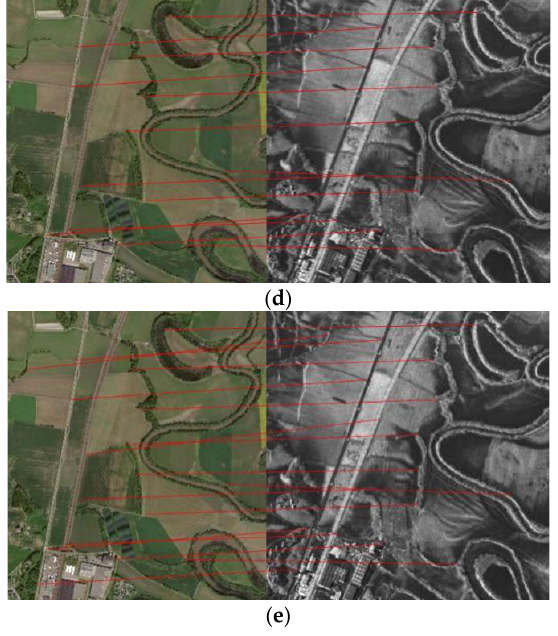
Figure 3. ( a ) Optical image; ( b ) SAR image; matches found in pair 2 using ( c ) SIFT, ( d ) SAR-SIFT, and ( e ) the proposed method. The reference image is shown on the left and the sensed image on the right.